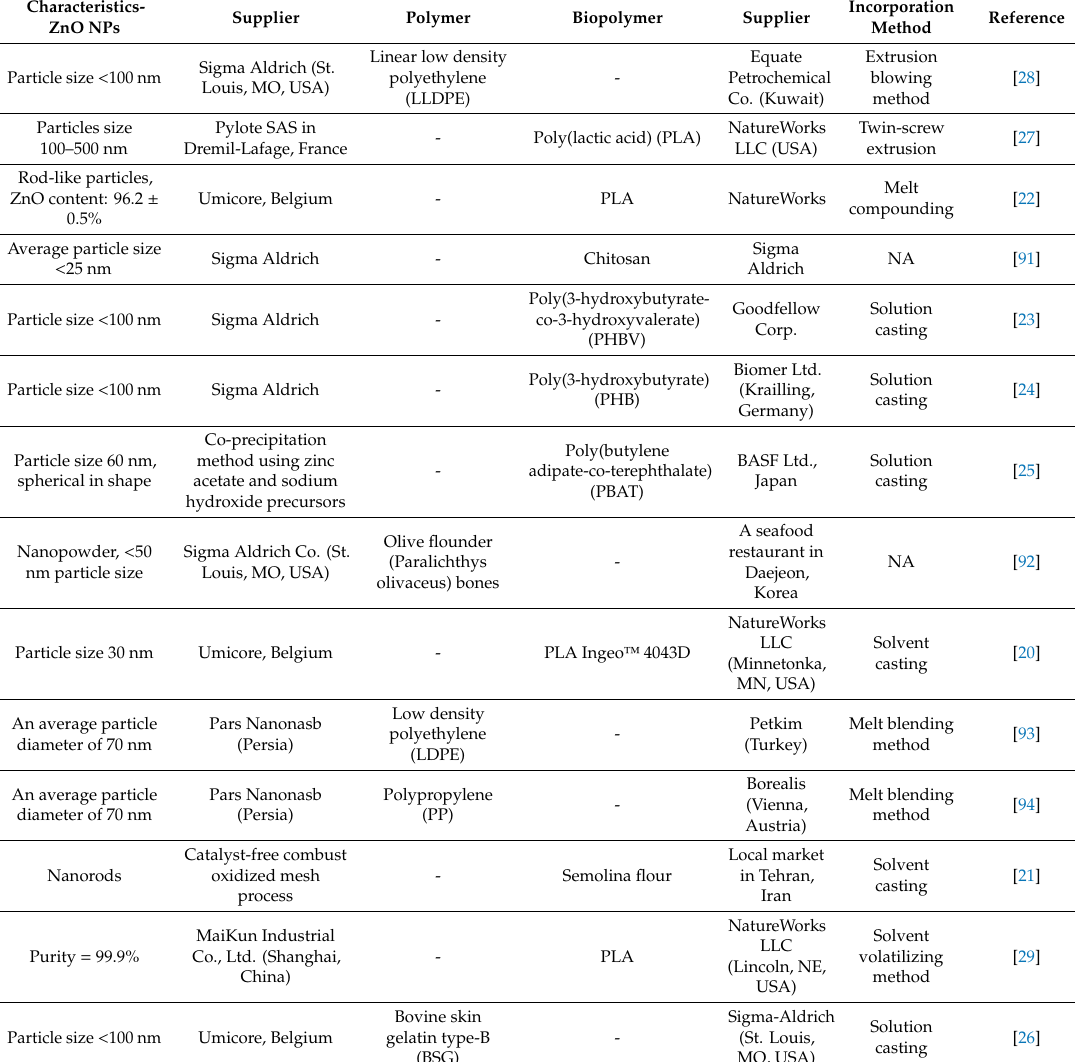
Table 3. ZnO NPs, (bio)polymers and incorporation / deposition methods to produce ZnO NPs based (bio)polymer